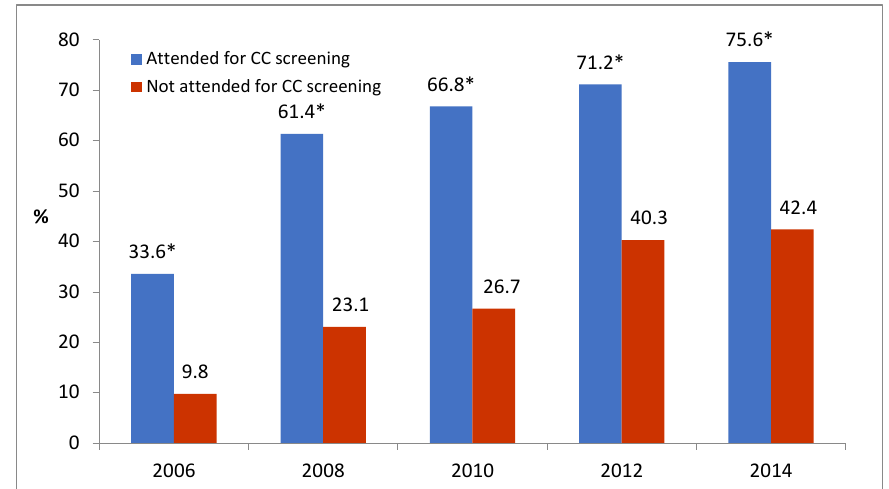
Figure 2. The proportion of women aged 50–60 years having had a mammogram within the last two years, according to attendance for cervical cancer screening in 2006–2014. * p < 0.001 compared with nonattenders; CC—cervical cancer. Table 3. Odds ratios of attendance for mammography screening within the last two years, according to sociodemographic and health-behavior factors and visits to a doctor (multivariate logistic regression